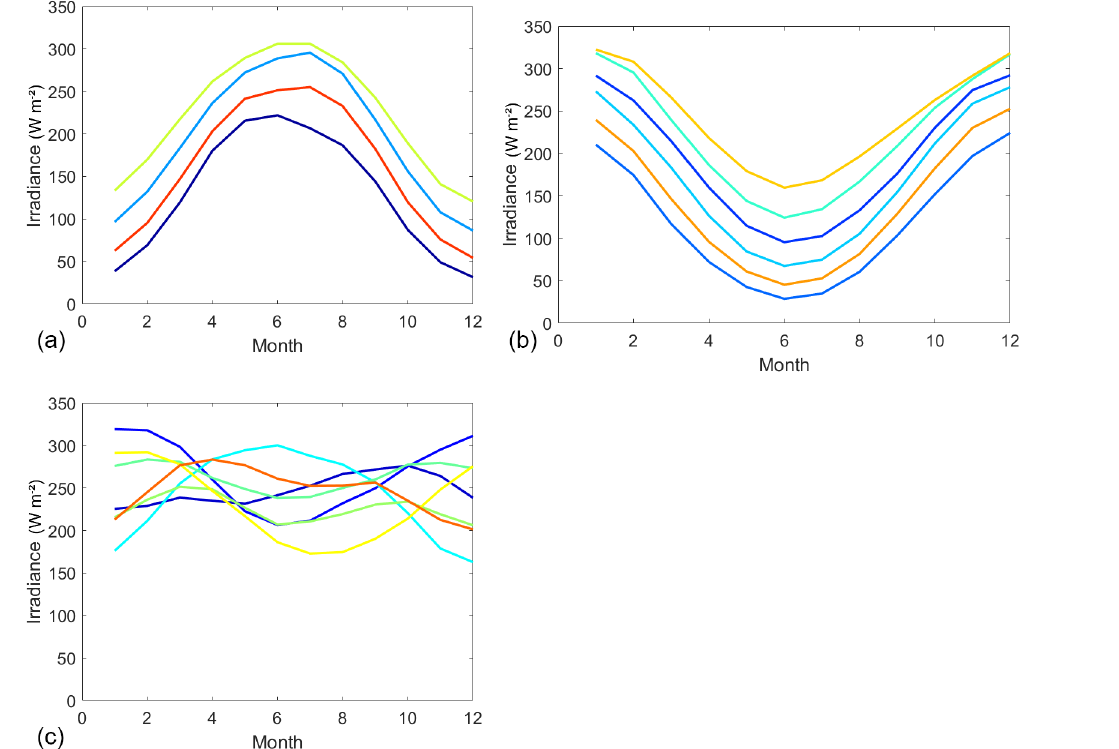
Figure 3. Typical profiles of DSIS for each class. Colours are the same as those in Fig. 3a. 4 northernmost classes (a) , 6 southernmost classes (b) , 7 tropical classes (c) .